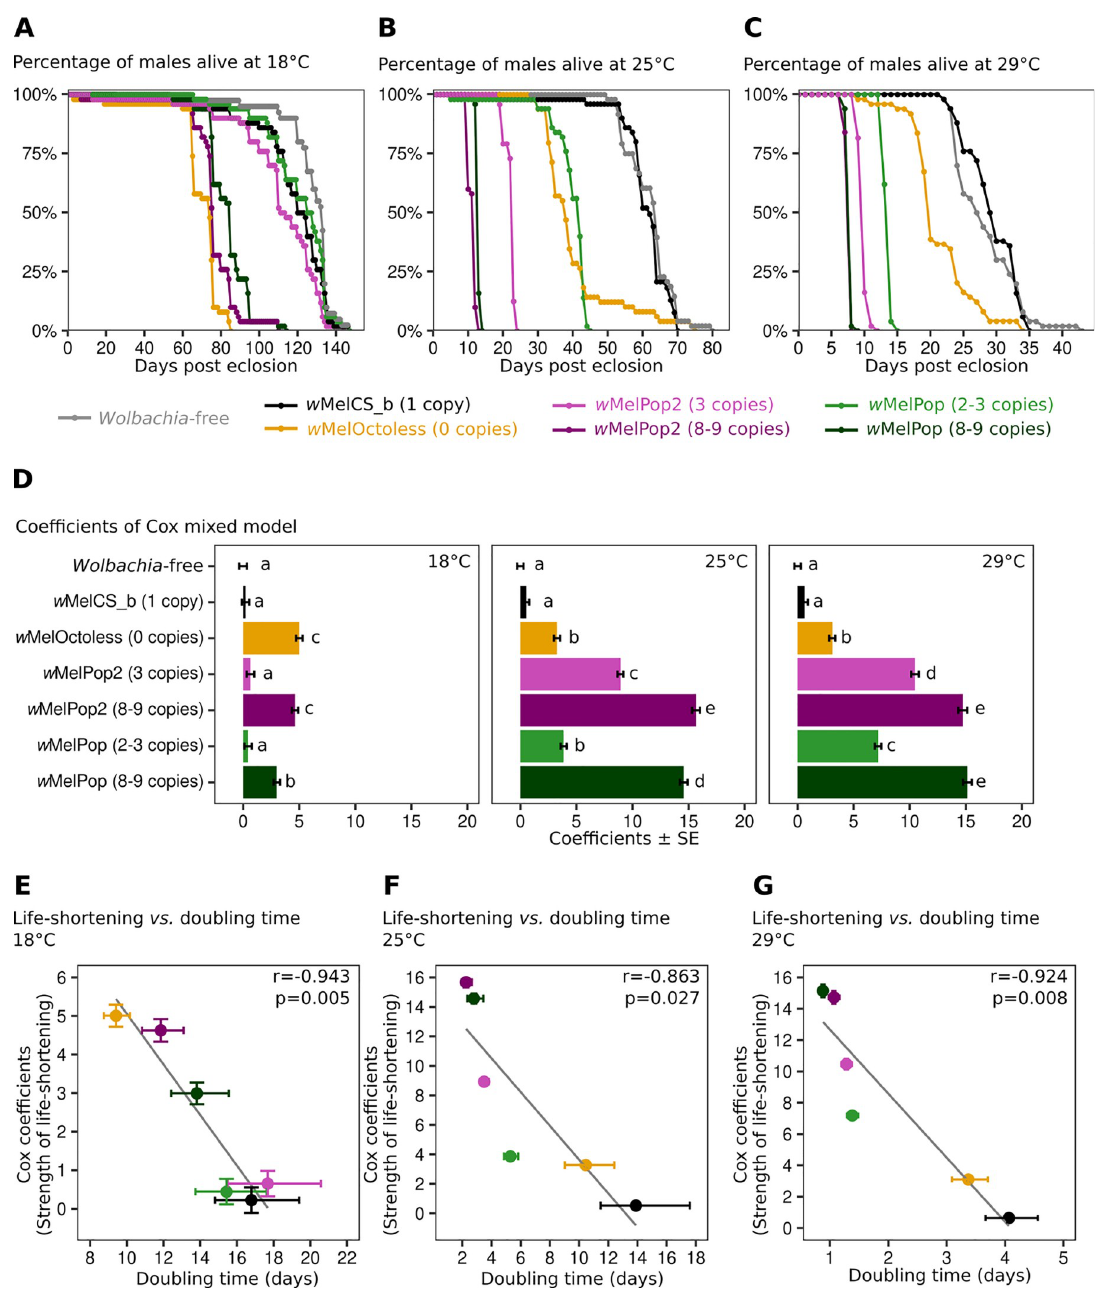
Fig 5. w MelOctoless and w MelPop2 are pathogenic. Lifespan of males with different Wolbachia variants at 18˚C (A), 25˚C (B), and 29˚C (C). For survival analyses, fifty males were collected on the day of eclosion and kept in groups of 10 per vial until all flies died. Flies were transferred to new vials every five days. A full replicate of these experiments is shown in S14A–S14C Fig. (D) Coefficients of a Cox mixed model, which represent the effect of Wolbachia on the lifespan of flies relative to the lifespan of Wolbachia -free flies. Both experimental replicates were analysed together. Bars represent the standard error of the coefficient, and letters statistically significant groups after p -value correction. (E-G) Correlation between the strength of life-shortening phenotype and Wolbachia doubling time at 18˚C (E), 25˚C (F), and 29˚C (G). The y-axis represents the strength of Wolbachia life-shortening phenotype (estimated using Cox mixed models) and the x-axis the Wolbachia doubling time (in days). The Pearson correlation coefficient ( r ) and its significance ( p ) are given in each